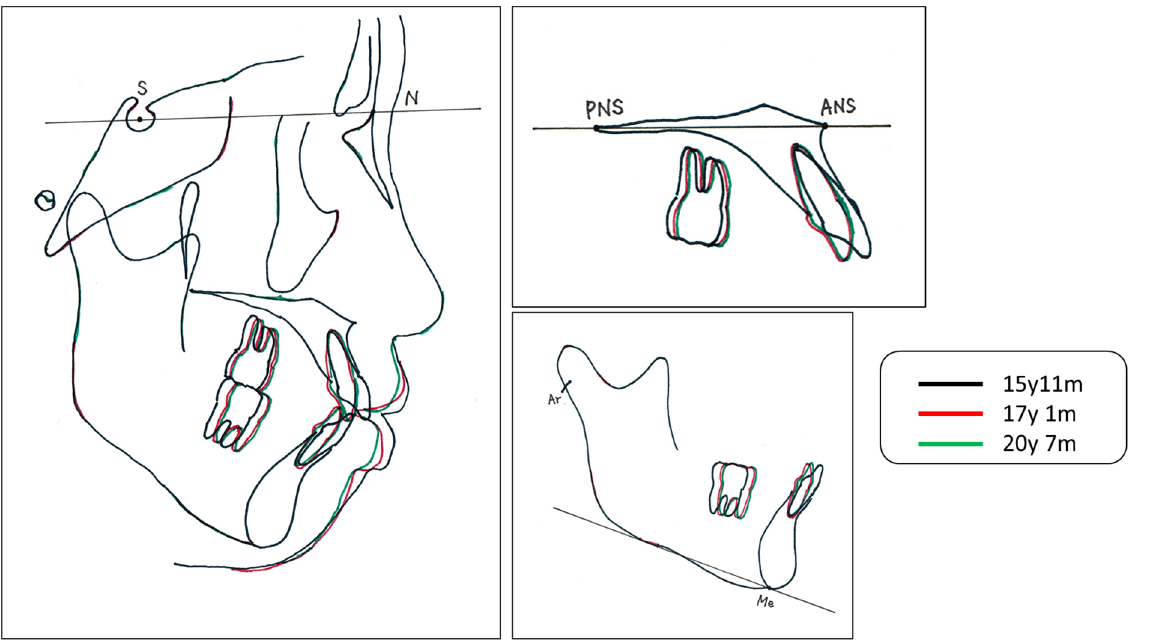
Figure 5. Cephalogram tracing. S; Sera turcica, N; Nasion, PNS; Posterior nasal spine, ANS; Anterior nasal spine, Ar; Articulare, Me; Menton.